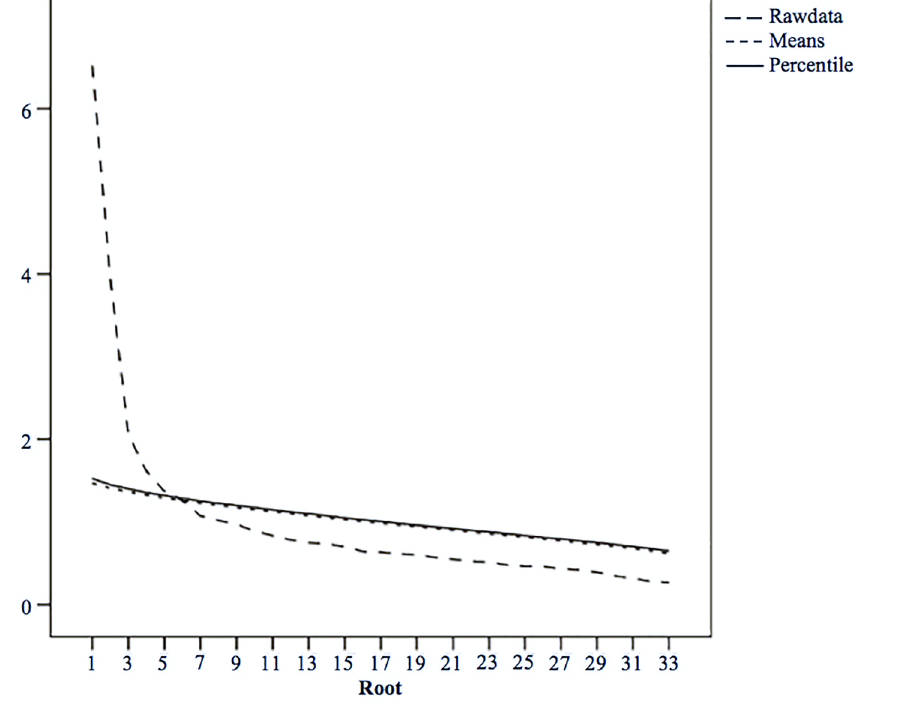
Fig 1. Parallel analysis scree-plot for the 33 music styles